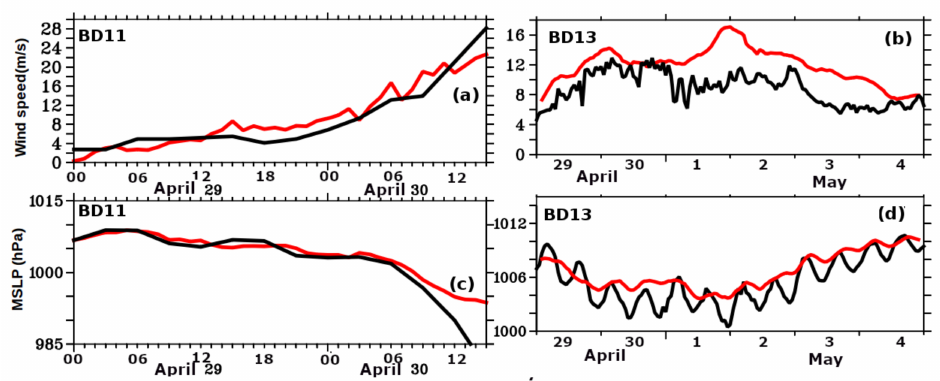
Figure 4. Comparison of model simulation (red) and observed (black) wind speed ( a , b ) (m/s) and mean sea level pressure ( c , d ) (hPa) at buoys BD11 and BD13 (buoy locations marked in Figure 3).